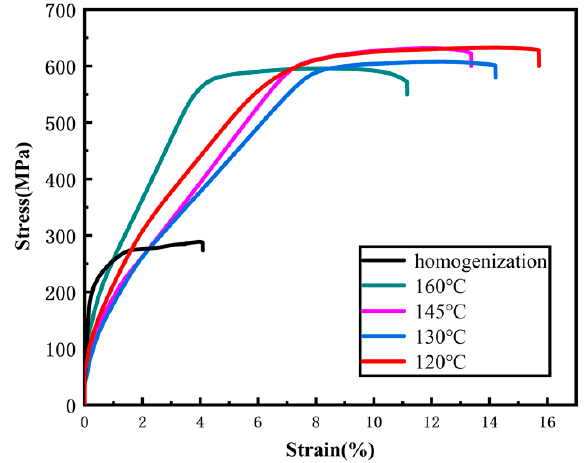
Figure 11. Mechanical properties of the alloy under the homogenization state and heat treatment parameters of the Cup-shaped component.